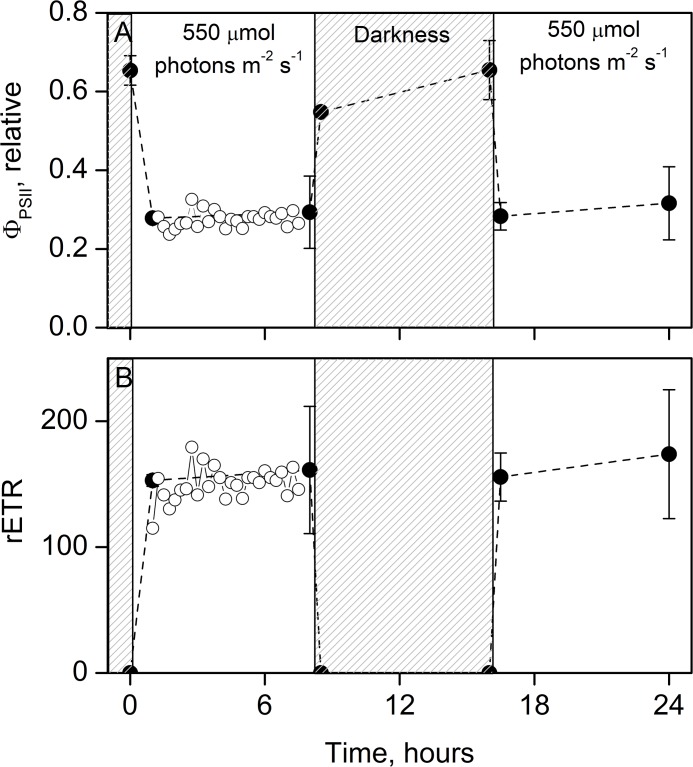
Variability of the photosynthetic efficiency during the 24h laboratory incubations.An example of (A) ΦPSII as a function of incubation time during the 8:8:8 hour light:dark:light regime, and the (B) corresponding relative electron transfer rate (rETR = ΦPSII × EPAR). Data are from GF7 5m incubated in the bath water (closed symbols, mean ± standard deviation, n = 3). Open symbols represent continuous measurements (every 15 min) of a subsample incubated inside the PAM fluorometer and shows the variability of ΦPSII under stable conditions. The latter was stable over time and the slope coefficient was not statistically different from zero, ANOVA P >>0.05.